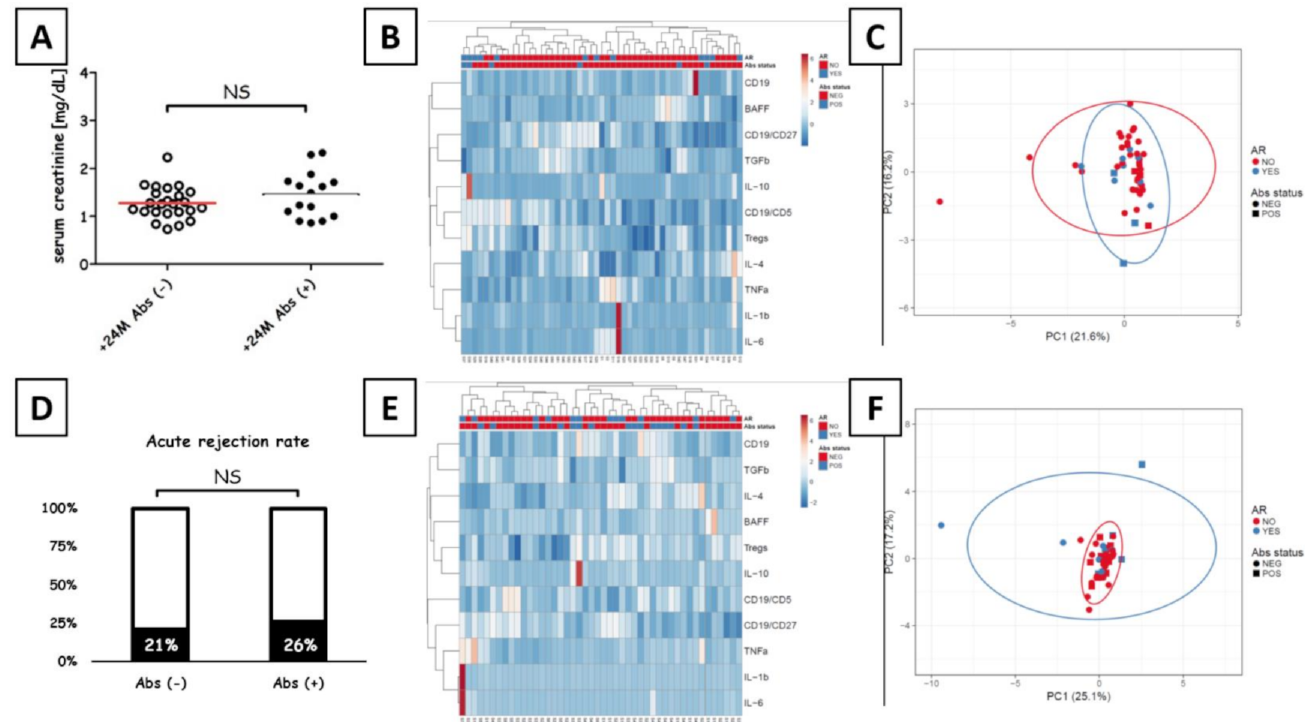
Figure 6. Kidney transplant outcome after 2 y. ( A ) Serum creatinine levels in Abs − and Abs+ measured for 2 y post- transplantation in the study population ( n = 52). Clustering and heat map analysis of patient profiles at transplantation ( B ) and 2 y later ( E ) did not reveal significant differences for either time point based on Euclidean distances between clusters. Principal component analysis on all parameters measured in Abs − and Abs+ kidney recipients, before ( C ) and 2 y after ( F ) the transplant. The analysis included 45 Abs − and 7 Abs+ recipients at transplant, along with 32 Abs- and 17 Abs+ recipients 24 months later. Unit variance scaling was applied to rows; SVD with imputation was used to calculate principal components. Respectively, principal components 1 and 2 explain 21.6% and 16.2% of total (pre-transplant variance, as well as 25.1% and 17.2% of total variance 2 y post-transplant ( n = 52 for both time points). A new observation from the same group will fall inside the prediction ellipse with a 0.95 probability. ( D ) The proportion of patients developing AR (in black) among the study population ( n = 52). Chi-squared tests revealed no significant differences (NS, not significant, p > 0.05). At 2 y post-transplant, the study included 32 Abs − patients and 17 Abs+